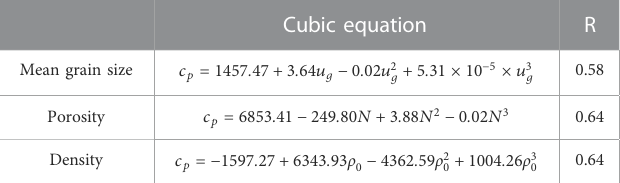
TABLE 3 Relationships of the compression wave speed with physical porosities. Cubic